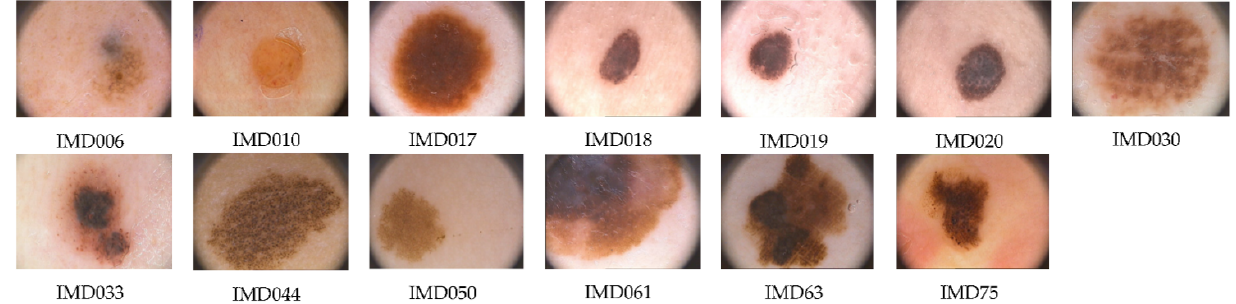
Figure 4. Image dataset NH13-data proposed in [37].